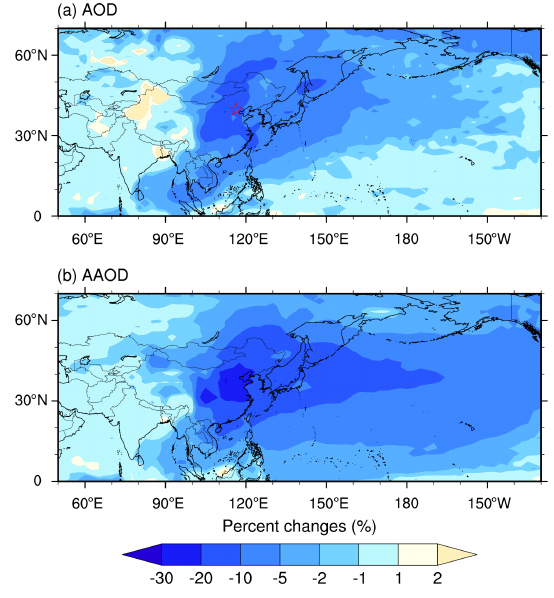
Figure 4. Map of the changes (%) in AOD (a) and AAOD (b) due to changes in anthropogenic emissions in China between 2008 (Exp08) and 2016 (Exp16). The location of the AERONET site is marked with a red star. AOD: aerosol optical depth; AAOD: absorp- tion aerosol optical